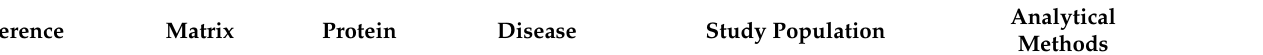
Table 3. Biomarkers in olfactory mucosa in the work-up of